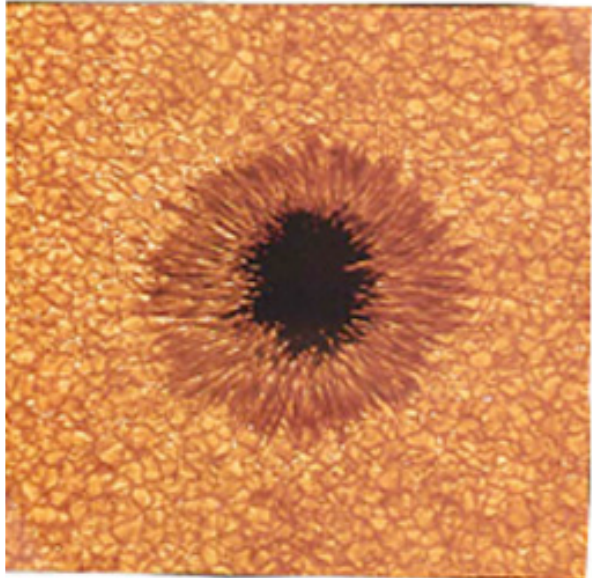
Fig. 2. An example of a single sunspot (courtesy of the Big Bear Solar Observatory).